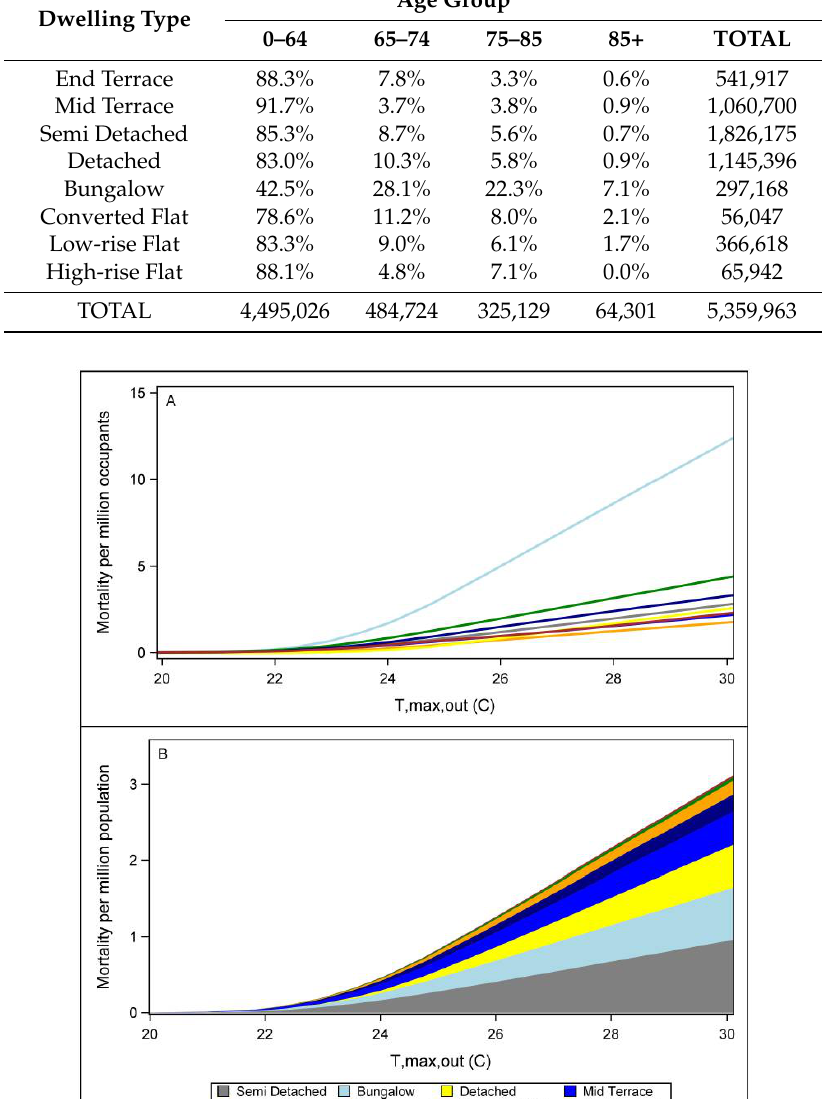
Table 2. Dwelling type by percent of residents within each age group, West Midlands.